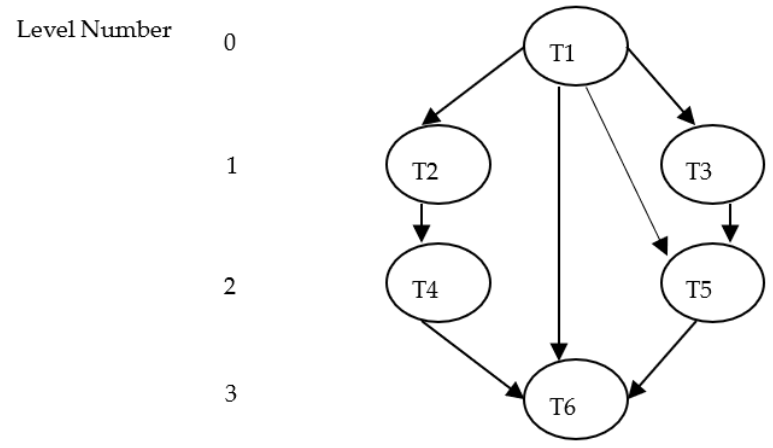
Figure 1. A model DAG.